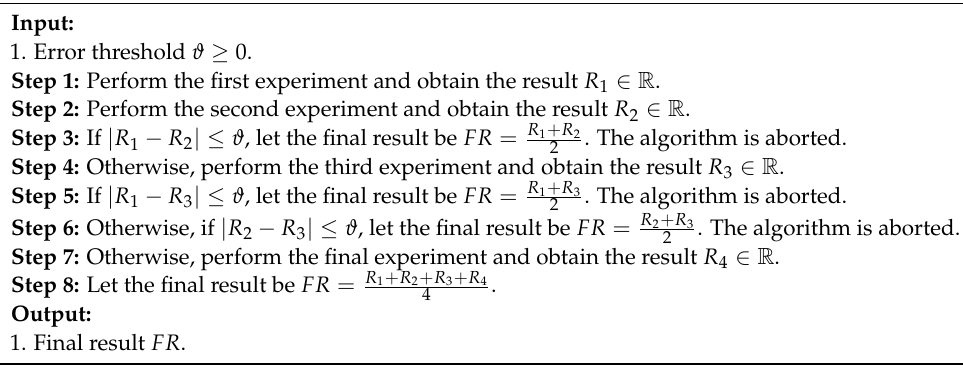
Algorithm 2: Four-test scoring method.